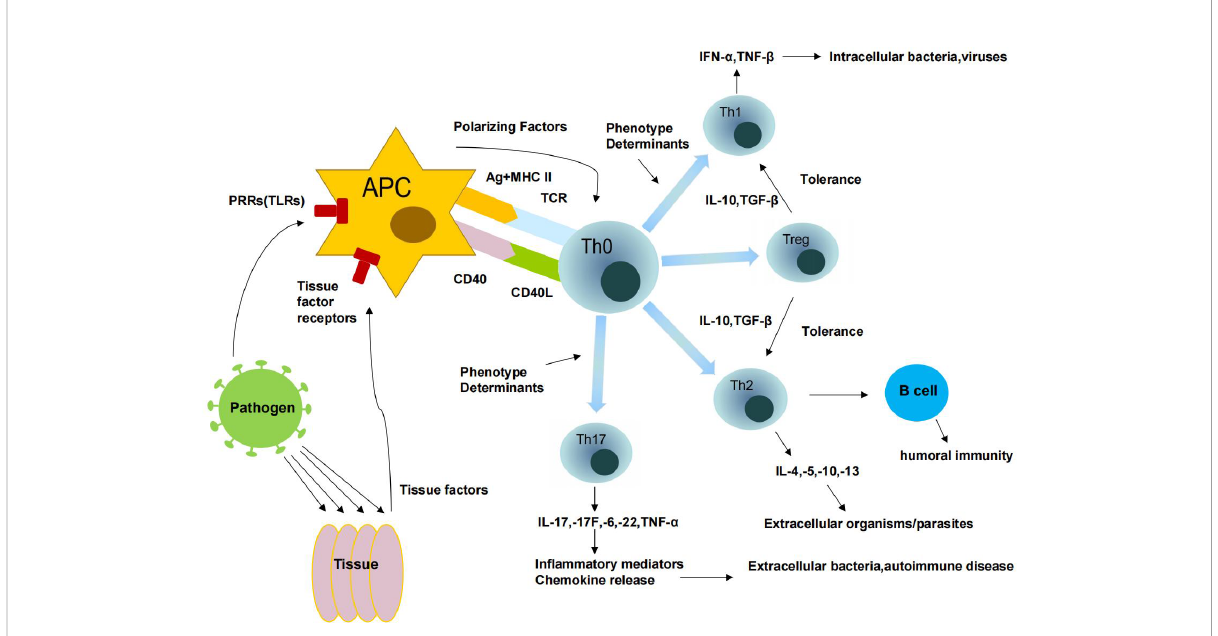
FIGURE 4 Immune response of T